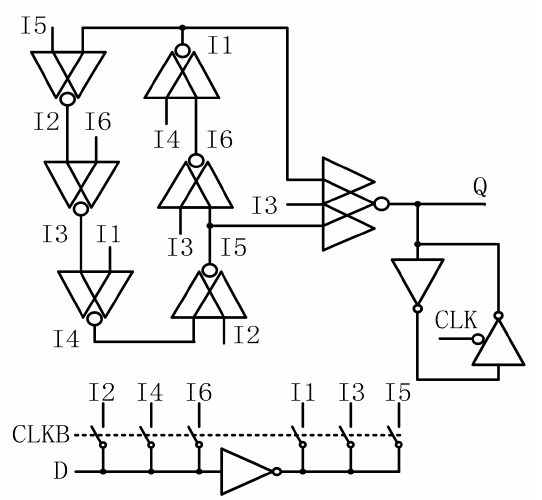
Figure 5. DNCS schematic.